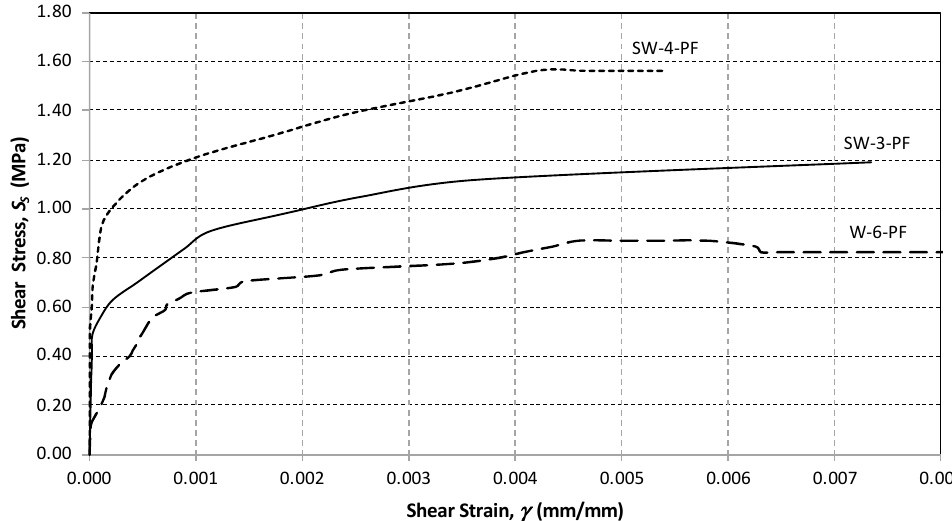
Figure 19. Shear stress versus shear strain plot (wall panels reinforced with polypropylene fibers).